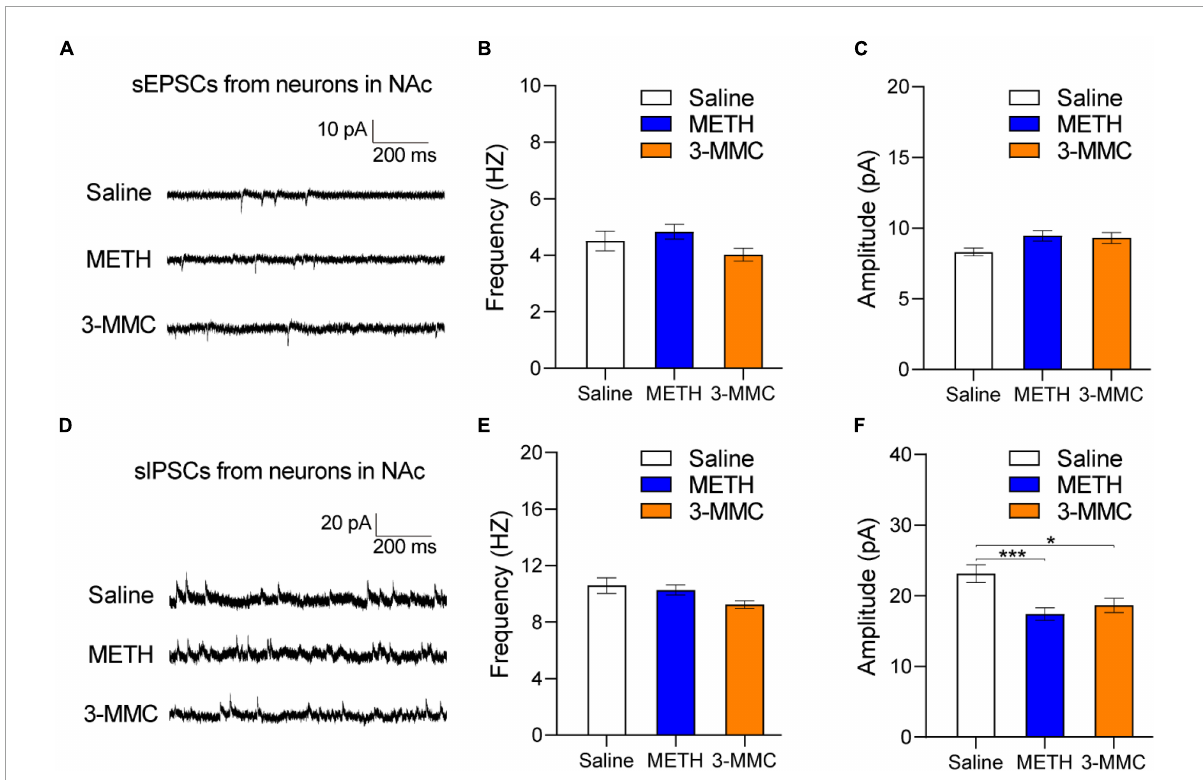
FIGURE4 Changes of synaptic transmission in nucleus accumbens (NAc) after chronic 3-MMC injection. (A) Representative sEPSCs traces recorded in NAC 24 h after the last injection of drugs. (B,C) No difference in the frequency and the amplitude of sEPSCs in NAc after chronic 3-MMC injection. (D) Representative sIPSCs traces recorded in NAC 24 h after the last injection of drugs. (E,F) The amplitude of sIPSCs was decreased after chronic 3-MMC injection without change of frequency of sIPSCs, post hoc test, * P < 0.05, *** P < 0.001 significant differences for 3-MMC vs saline and METH vs saline respectively. For slice electrophysiology: 25 neurons from three rats with saline injection, 32 neurons from three rats with METH injection and 27 neurons from three rats with 3-MMC injection. Data are presented as mean values ± SEM.